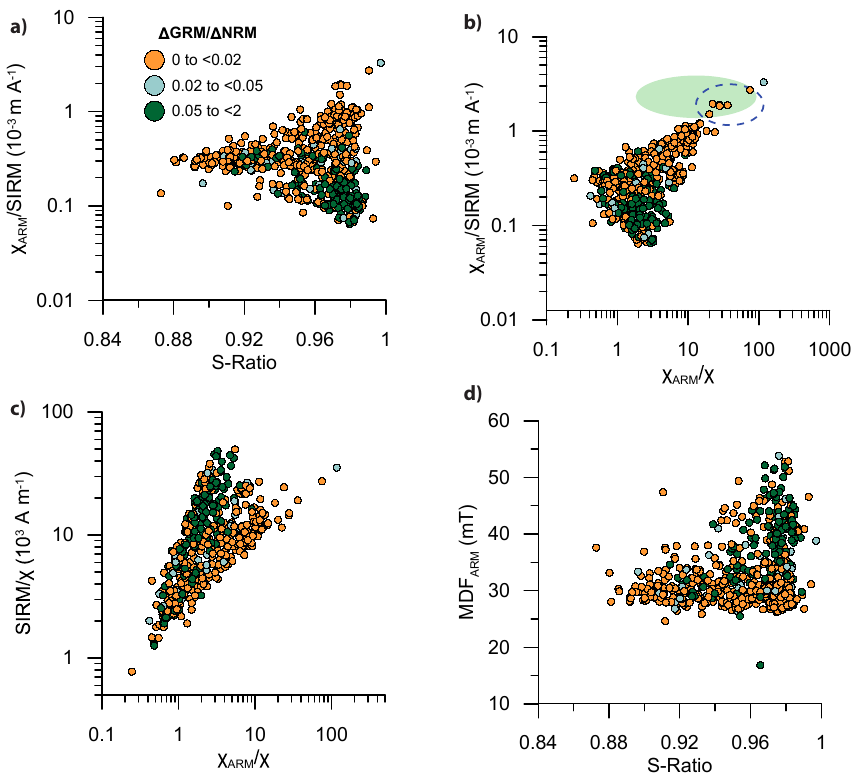
Figure 4. Selected cross plots of magnetic proxy evaluation. Samples that acquire GRM (color code) cluster in different regions of the diagrams. (a) GRM samples are characterized by high S ratios. A linear relationship between χ ARM / SIRM and S ratio relates to co-varying ferrimagnetic grain-size fining and increasing low- vs. high-coercivity magnetic mineral content. (b) GRM samples plot at χ ARM / SIRM levels typical of authigenic, inorganically precipitated greigite. A few samples from the uppermost part of the core plot in the field of bacterial magnetite (dashed circle; Snowball, 1994) and greigite (green shaded area; Reinholdsson et al., 2013). (c) GRM samples have a distinctively different gradient compared to non-GRM samples in the SIRM /χ vs. χ ARM /χ plot. (d) GRM samples are characterized by high S ratios and high MDF (ARM) . Non-GRM samples show no relationship between the two parameters.